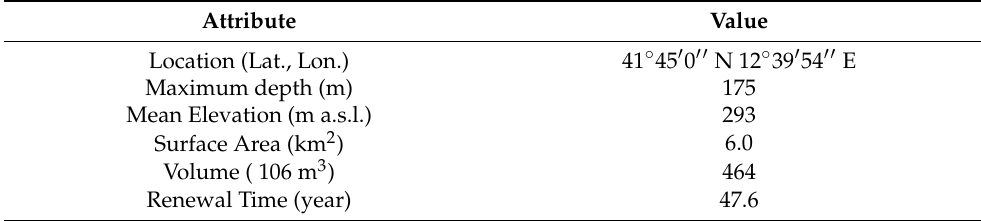
Table 1. Main morphometric and hydrological features of Lake Albano. Attribute Value Location (Lat.,